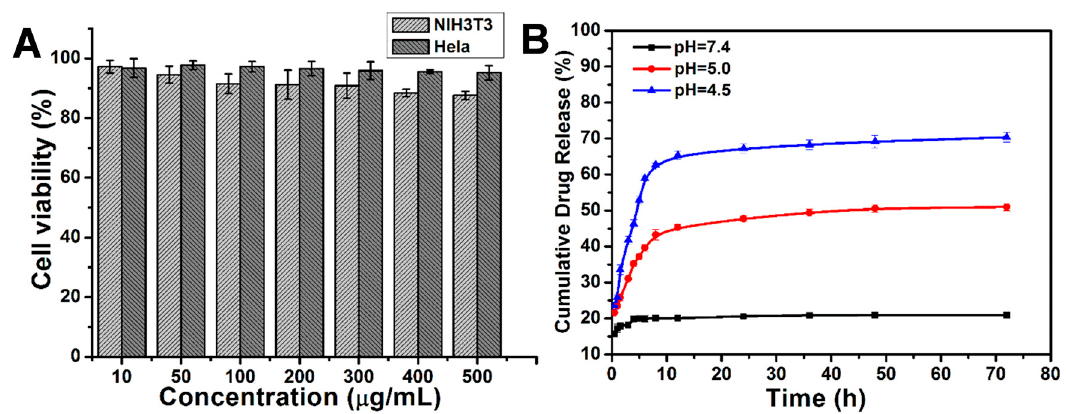
Figure 4. ( A ) Viability of NIH3T3 and HeLa cells incubated with different concentrations of pseudopolyrotaxanes micelles for 48 h. ( B ) Release profiles of DOX from DOX / pseudopolyrotaxanes at pH 7.4, 5.0, and 4.5.